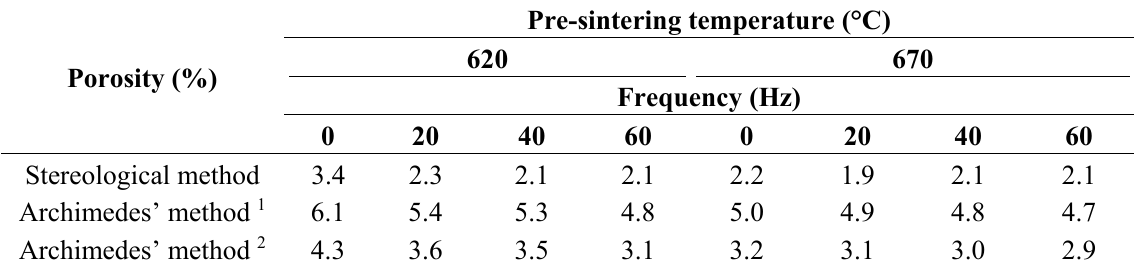
Table 3. The FeAl sinters porosity calculated by planimetric and Archimedes methods.